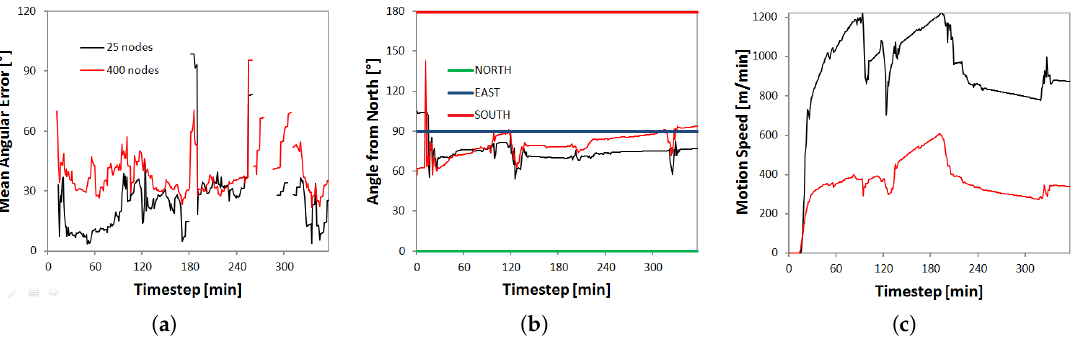
Figure 10. Results of the motion estimation algorithm for the two different node densities. ( a ) Time series mean angular error; ( b ) time series of estimated motion direction averaged over all nodes; ( c ) time series of estimated motion speed averaged over all